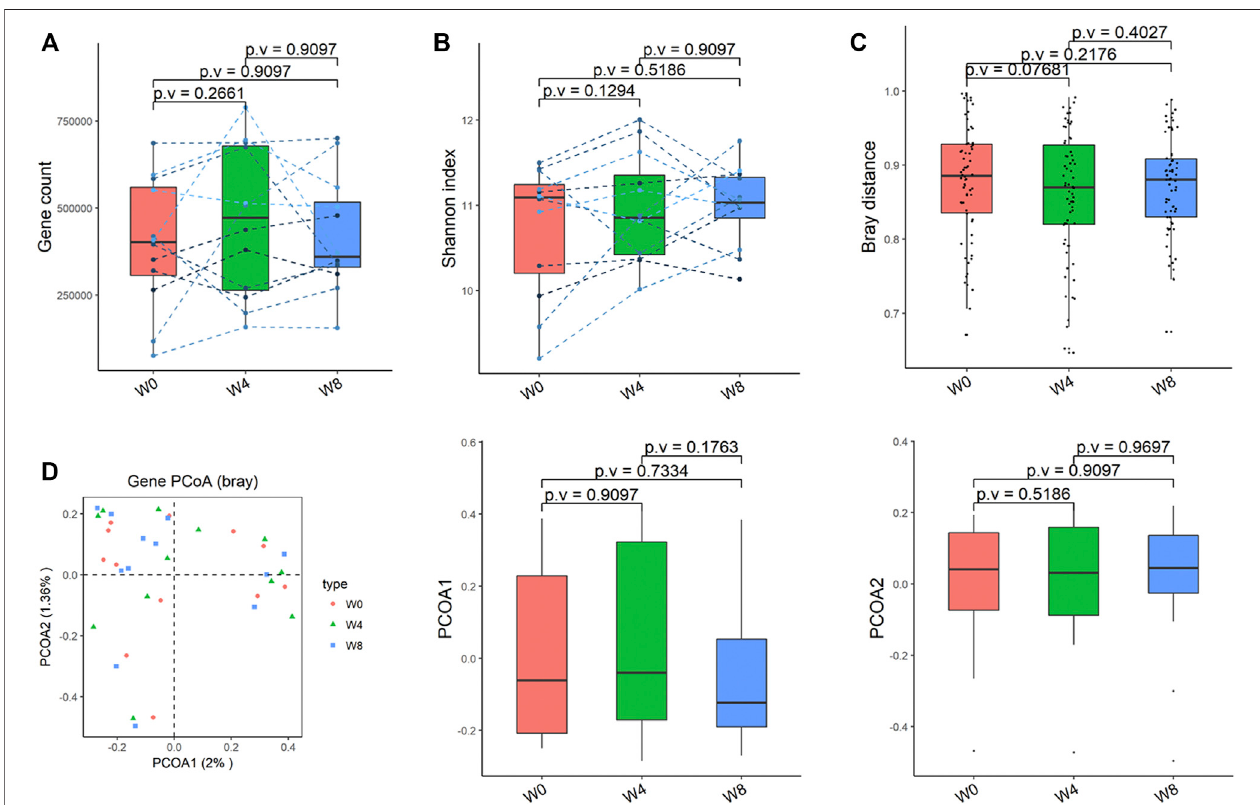
FIGURE 1 | Alpha-diversity, beta-diversity, and principal component analysis at the gene level. (A) Gene count detected was not signi fi cantly different in comparisons between W0 and W4, W0 and W8, and W4 and W8. (B) Shannon index was not signi fi cantly different in comparisons between W0 and W4, W0 and W8, andW4andW8 (C) Nosigni fi cantdifferenceinbetadiversitybasedonBray-Curtis(Bray)distanceforW0vsW4,W0vsW8,andW4vsW8. (D) PCoAanalysisbasedon Bray distance showed that the fi rst principal component was not signi fi cantly different in W0 vs W4, W0 vs W8, and W4 vs W8, nor the second